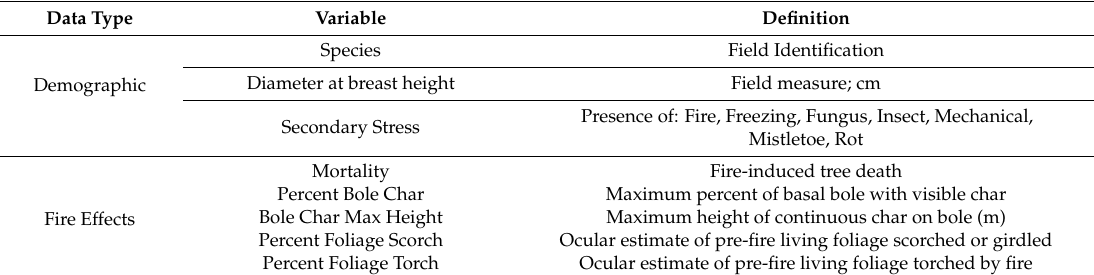
Table 2. Tree-level demographic and fire effect